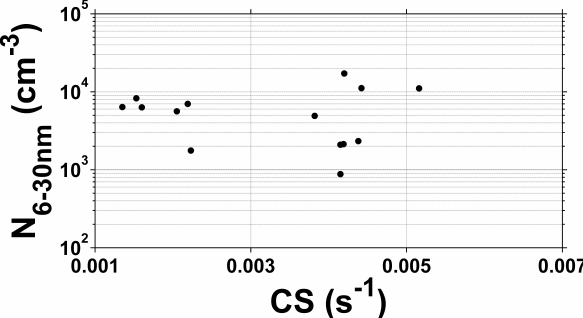
Fig. 5. Scatterplot of condensational sink (CS) (s − 1 ) and D p = 6– 30nm particle number concentrations (cm − 3 ) . CS is computed for all event days during NIFTy for the period 1 h prior to the maximum rate change of 10nm